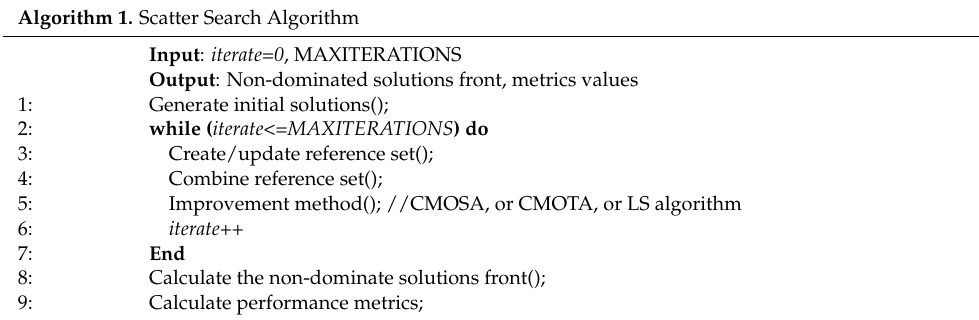
Algorithm 1. Scatter Search